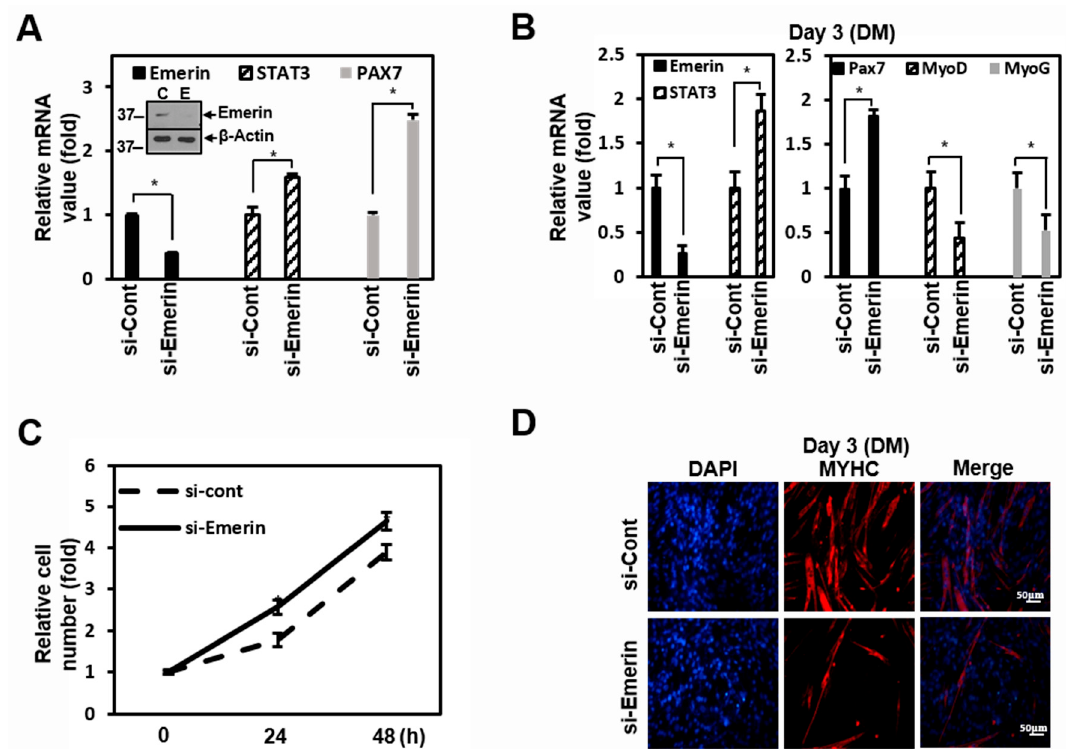
Figure 4. Emerin regulates muscle cell proliferation through STAT3 signaling. ( A ) C2C12 cells were treated with siRNA (100 nM) against Emerin or control for 48 h in 6-well plates. The total RNA was isolated and subjected to a qRT-PCR analysis. Data were normalized to β -Actin . Treated cells were lysed and subjected to western blotting with antibodies against emerin and β -actin (inner panel). The results are presented as the mean ± SD of three independent experiments performed in triplicate. * p < 0.05. ( B ) C2C12 cells were treated with siRNA (100 nM) against Emerin or control for 48 h in 6-well plates. After 48 h, cells were treated with differentiation media (DM) for 3 days. The total RNA was isolated and subjected to qRT-PCR analysis. Data were normalized to β -Actin . The results are presented as the mean ± SD of three independent experiments performed in triplicate. * p < 0.05. ( C ) C2C12 cells were treated with siRNA (100 nM) against Emerin or control for 24 or 48 h in 6-well plates. Cells were fixed each time and the relative cell number was counted at each time point. The results are presented as the mean ± SD of three independent experiments performed in triplicate. ( D ) C2C12 cells were treated with siRNA (100 nM) against Emerin or control for 48 h in 6-well plates. After 48 h, cells were treated with differentiation media (DM) for 3 days. Immunocytochemistry image stained with anti-MYHC antibody from emerin-depleted C2C12 cells at day 3 of differentiation. DAPI (blue) was used to visualize nucleus. Scale bar = 50 µ